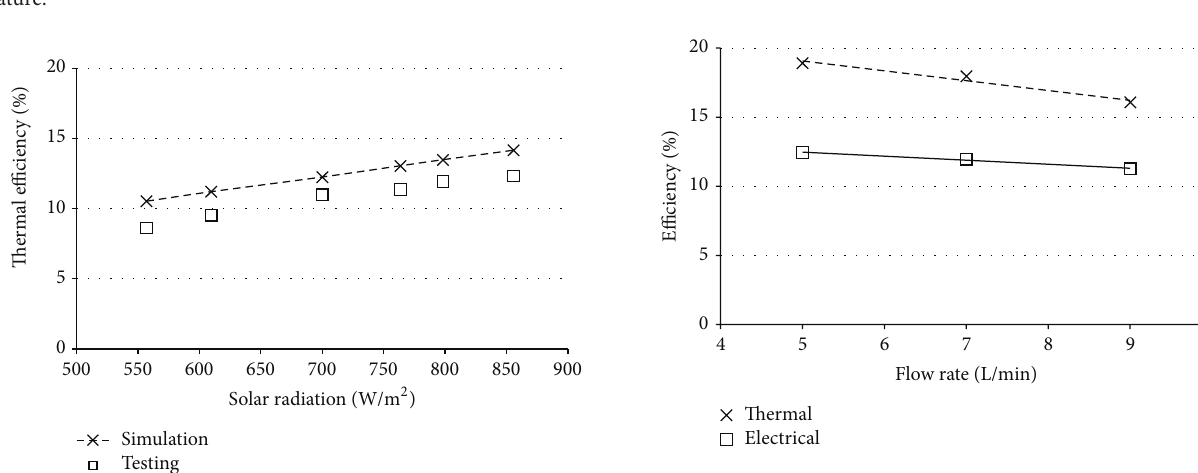
Figure 10: Variation of electrical and thermal efficiencies with flow